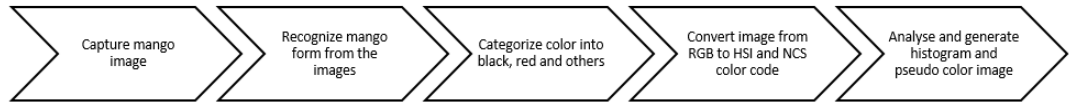
Figure 3. Flowchart for mango color processing using a computer vison system with CCD camera and output. RGB: red, green, and blue color space; HSI: hue, saturation, and intensity color system; NCS: Natural Color Standard.